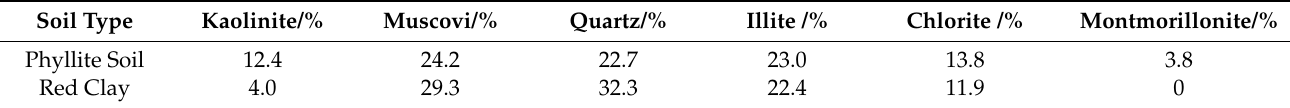
Table 3. Relative content of phyllite soil and red clay minerals.